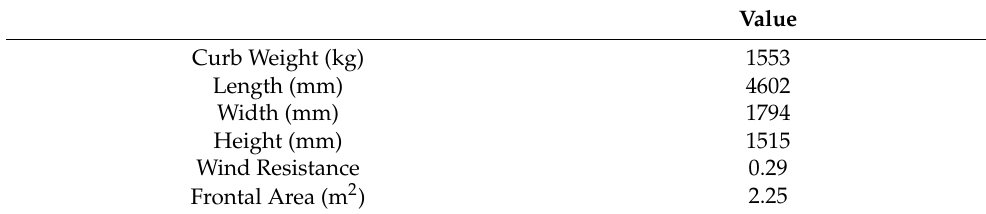
Table 1. Body Parameter of the vehicle.